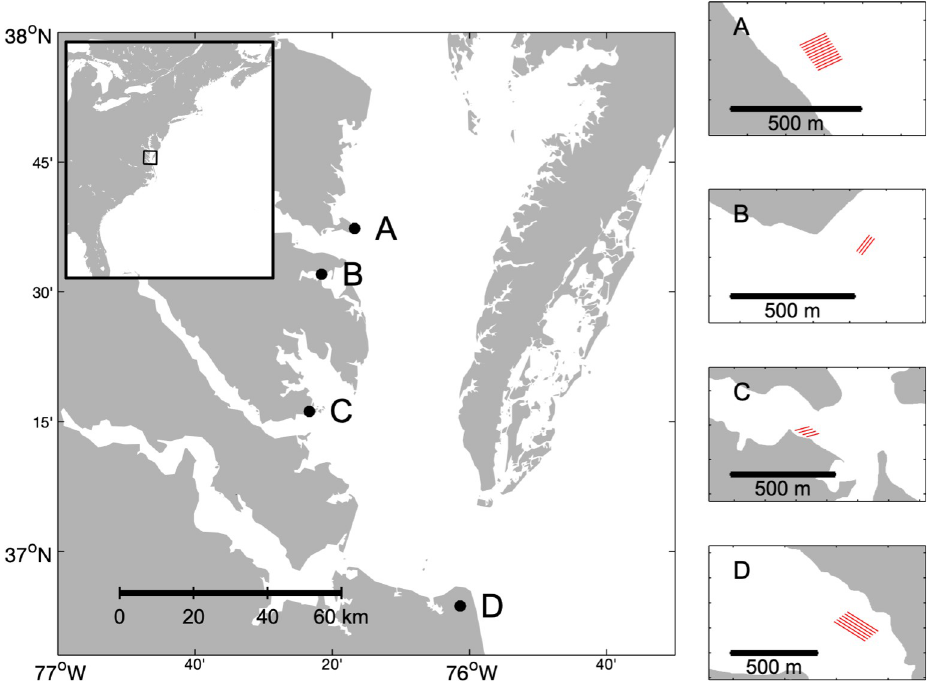
Fig 1. Map of study sites. The aquaculture sites sampled 2017–2018, from north to south: Windmill Point (A) near the mouth of the Rappahannock River; Bland Point (B) in the Piankatank River; Monday Creek (C) in the marshes bordering the southwestern entrance to Mobjack Bay and the mouth of the York River, and Broad Bay (D) in the Lynnhaven River system. Red lines indicate spatial extent and orientation of the cages at each site but do not correspond directly to rows in the array of cages at each